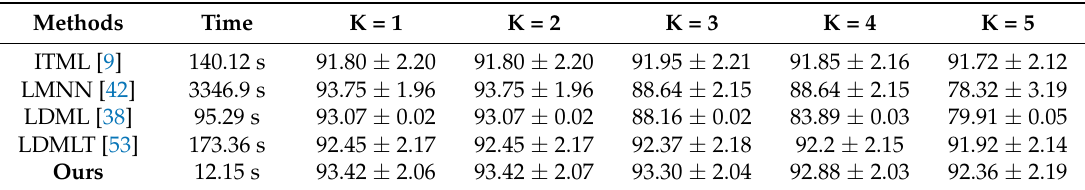
Table 4. The average of recognition rate (%) and training time for different metric learning methods in the WPUT database.